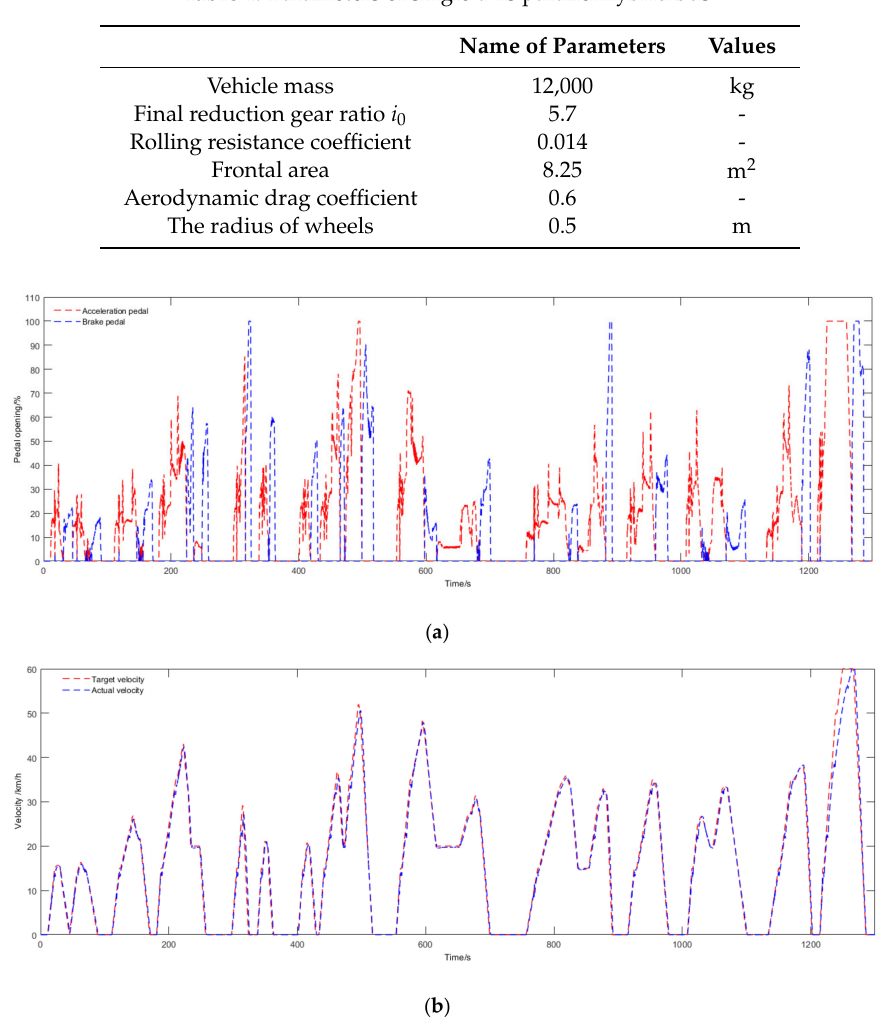
Table 4. Parameters of single-axis parallel hybrid bus.